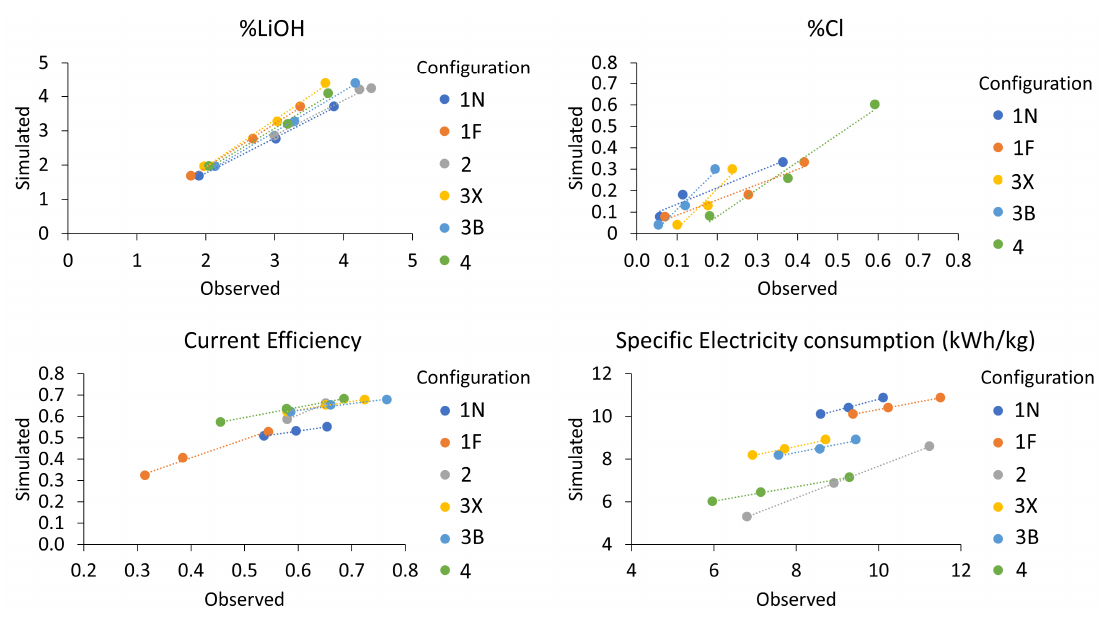
Figure 6. Comparison of observed and predicted values of LiOH concentration, Cl − concentration, current efficiency and SEC.